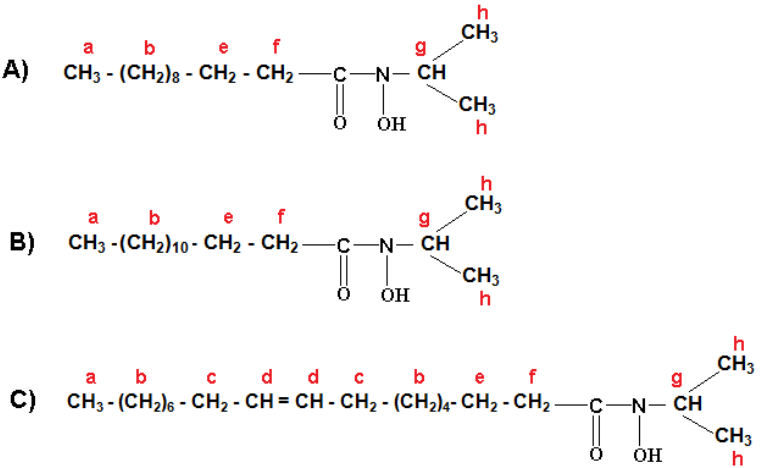
Figure 4. Formulation of isoprophyl laureo hydroxamic acid (A); isoprophyl myristo hydroxamic acid (B); isoprophyl oleo hydroxamic acid (C).